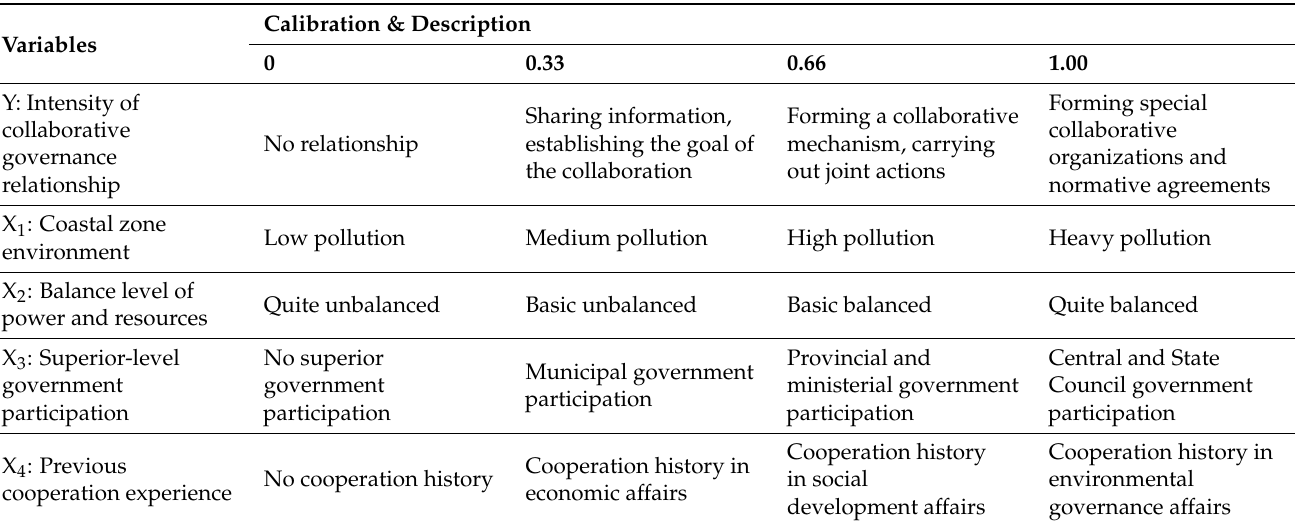
Table 3. Variables and calibration regarding economic cooperation, social development cooperation, and environmental governance